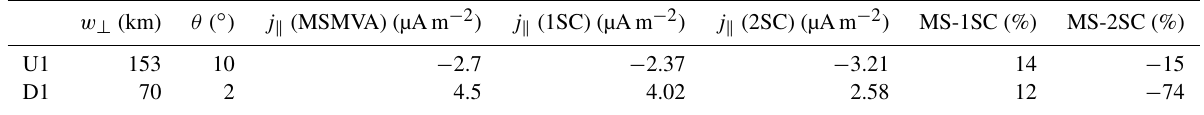
Table 1. Comparison of the FAC estimates for 17 February 2017. Columns show perpendicular scale, FAC inclination, FAC density from multiscale, single- and dual-spacecraft, and the relative differences between the FAC densities.